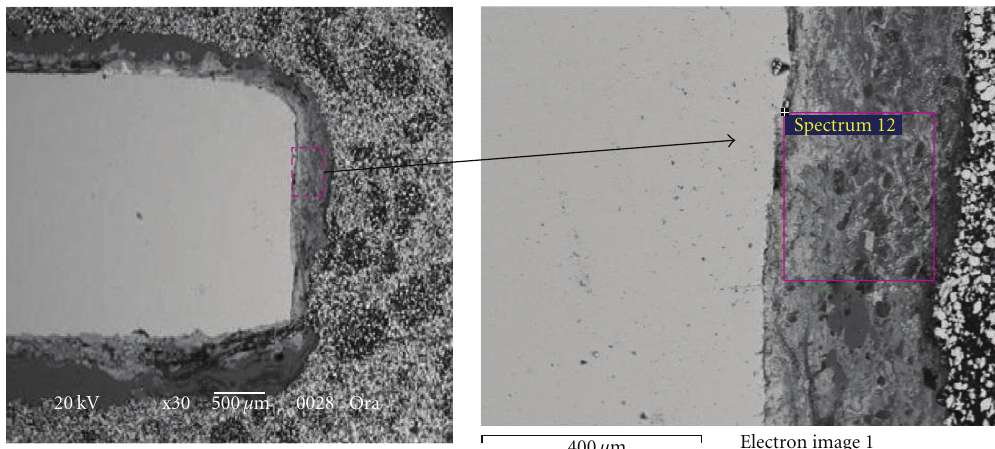
Figure 11: Thermal-sprayed Zn/Al double layer, without sealer. Thickness = 345.44 μ m. View in the SEM. Right edge.